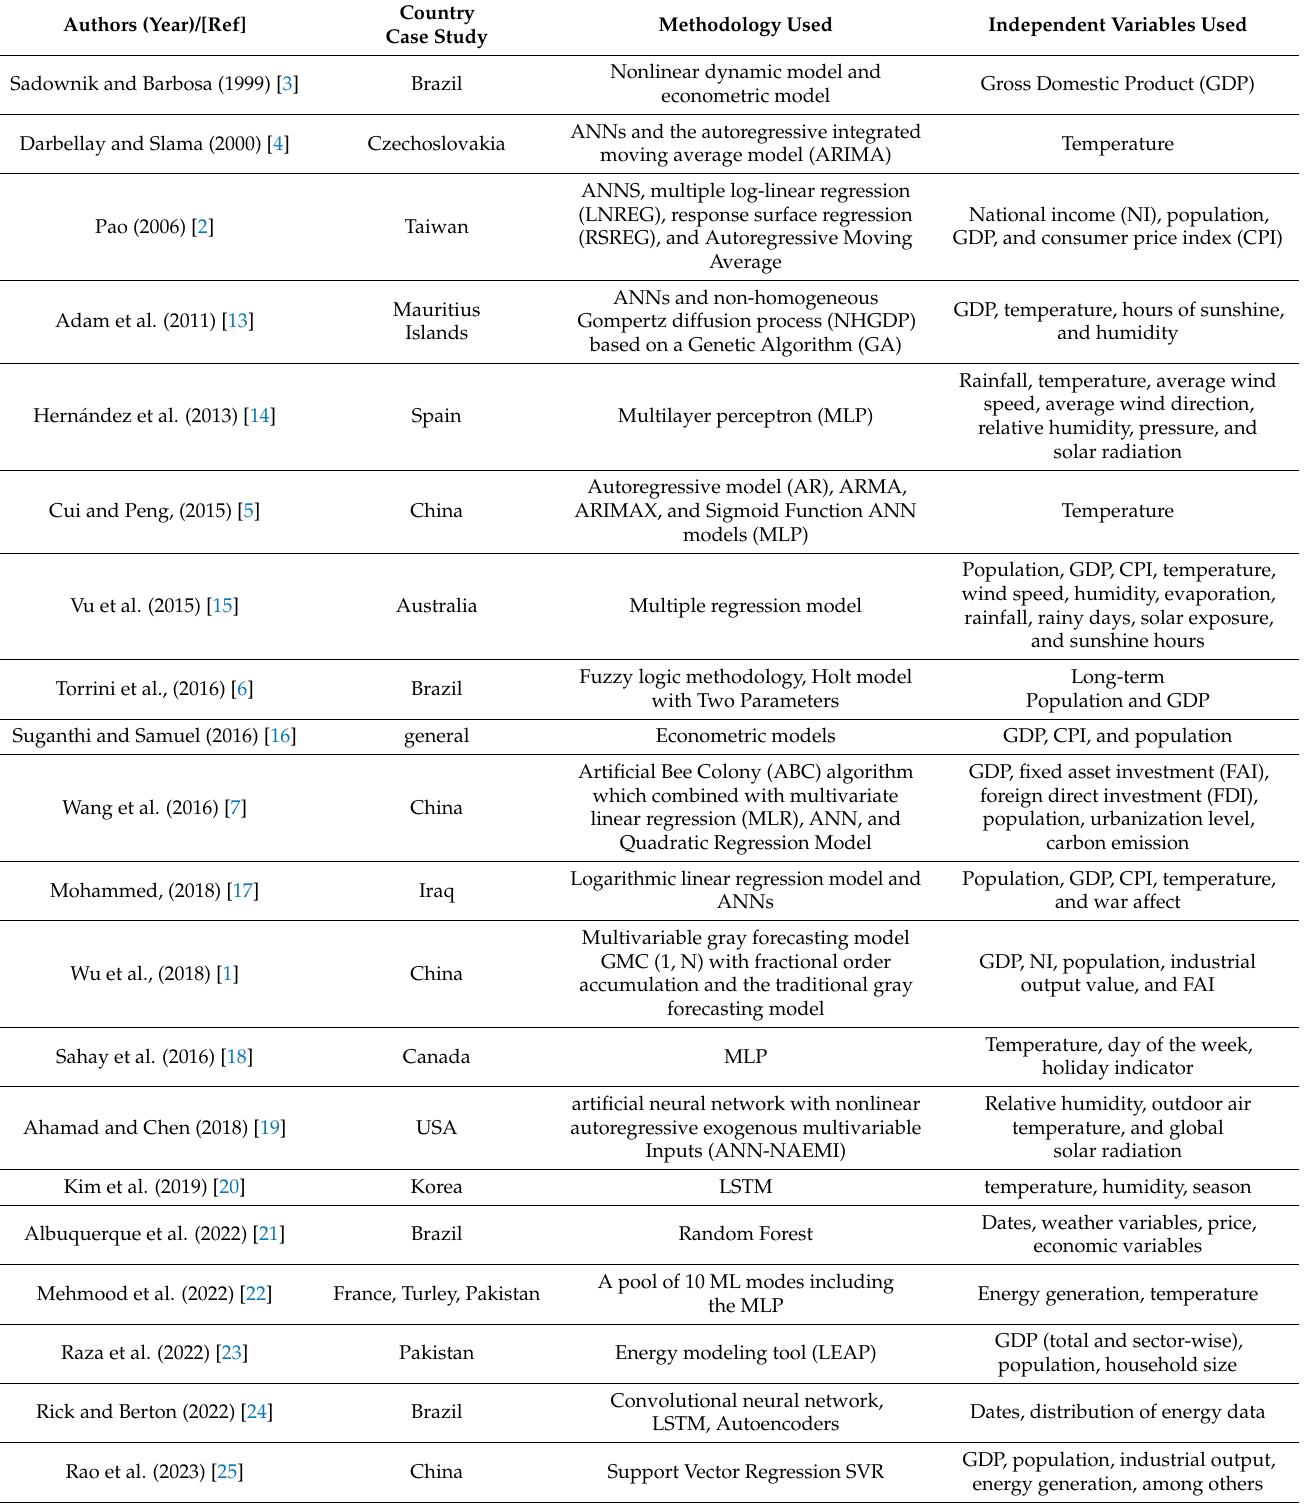
Table 1. Articles related to the research